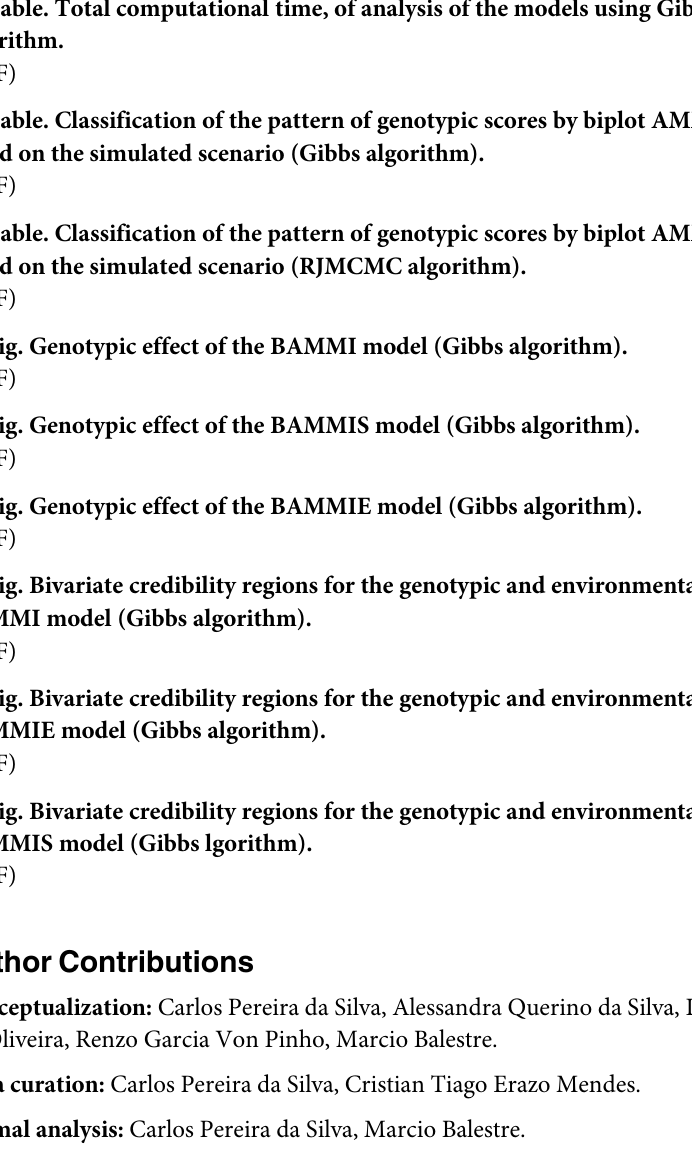
S6 Table. Correlation and PRESS for the models (RJMCMC). (PDF) S7 Table. Total computational time, of analysis of the models using Gibbs and RJMCMC algorithm. (PDF) S8 Table. Classification of the pattern of genotypic scores by biplot AMMI2 representation based on the simulated scenario (Gibbs algorithm). S9 Table. Classification of the pattern of genotypic scores by biplot AMMI2 representation based on the simulated scenario (RJMCMC algorithm). S1 Fig. Genotypic effect of the BAMMI model (Gibbs algorithm). S2 Fig. Genotypic effect of the BAMMIS model (Gibbs algorithm). S3 Fig. Genotypic effect of the BAMMIE model (Gibbs algorithm). S4 Fig. Bivariate credibility regions for the genotypic and environmental scores of the BAMMI model (Gibbs algorithm). S5 Fig. Bivariate credibility regions for the genotypic and environmental scores of the BAMMIE model (Gibbs algorithm). S6 Fig. Bivariate credibility regions for the genotypic and environmental scores of the BAMMIS model (Gibbs